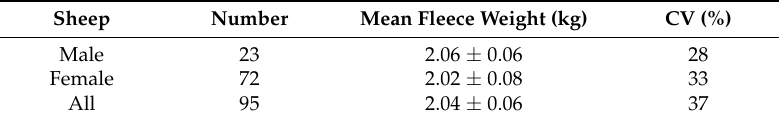
Table 1. The average weight of greasy wool per